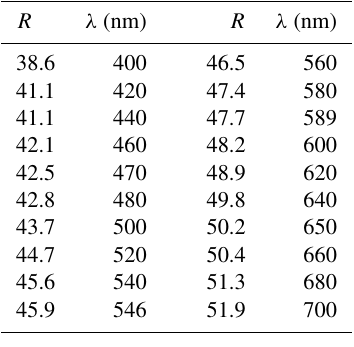
Figure 2. Reflectivity curve for grimmite from